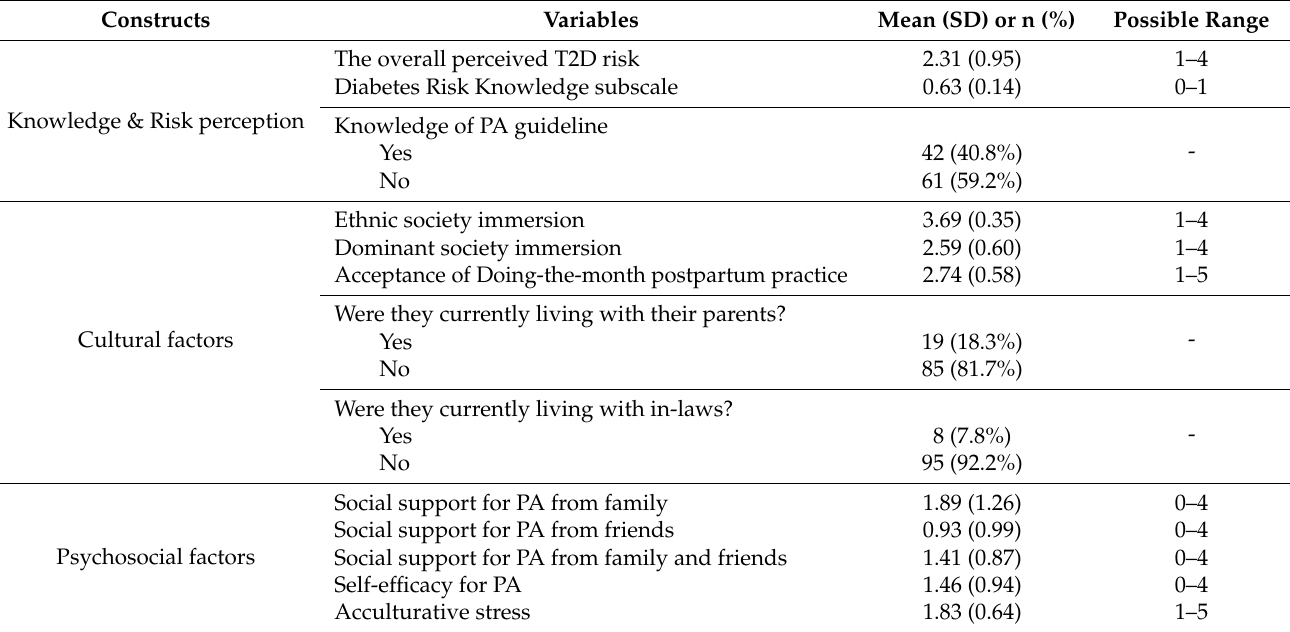
Table 2. Risk perception, knowledge, cultural and psychosocial characteristics of Chinese immigrants in the US with prior GDM (n = 106).